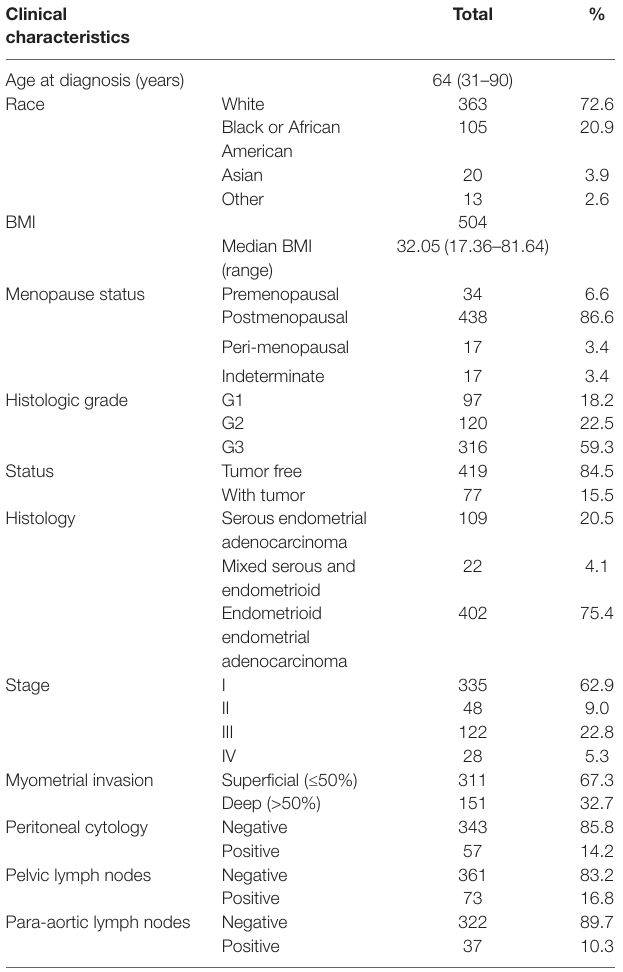
TABLE 3 | Clinical characteristics of TCGA EC patients. Clinical characteristics